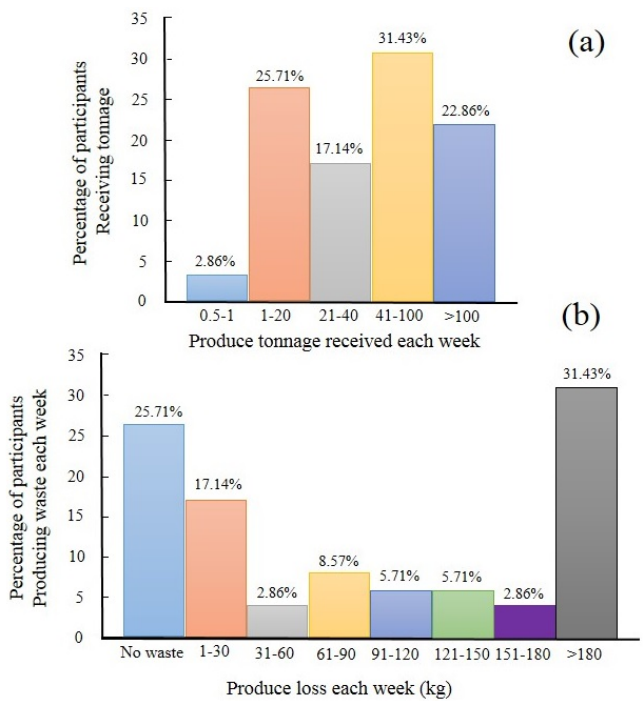
Figure 3. ( a ) Percentage breakdown of weekly tonnage of supplied fresh fruits and vegetables; and ( b ) percentage breakdown of respective loss levels reported by each respective